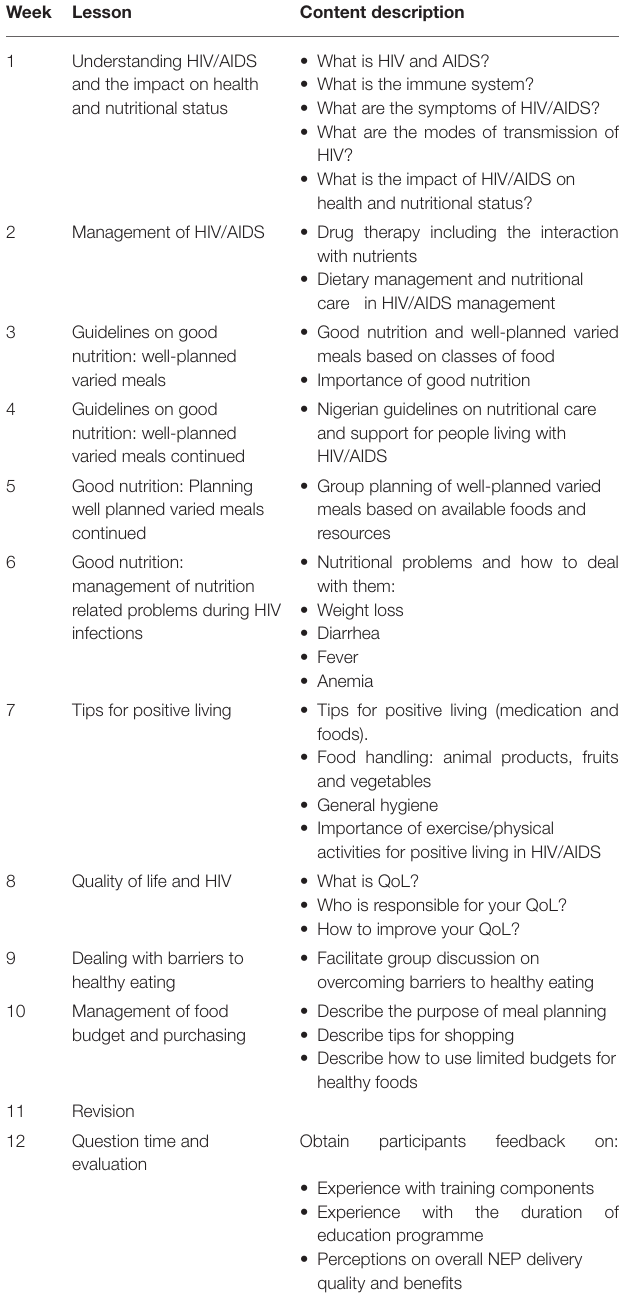
TABLE 2 | Nutrition education programme